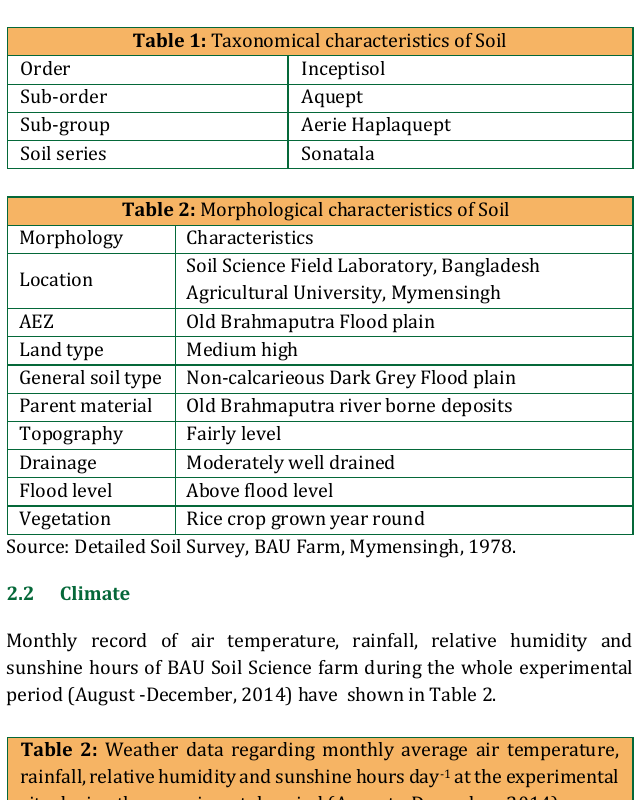
Table 2: Nutrient contents in organic